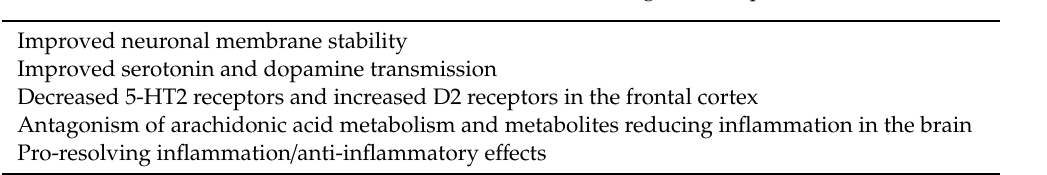
Table 2. Possible mechanisms for the benefits of omega-3s in depression